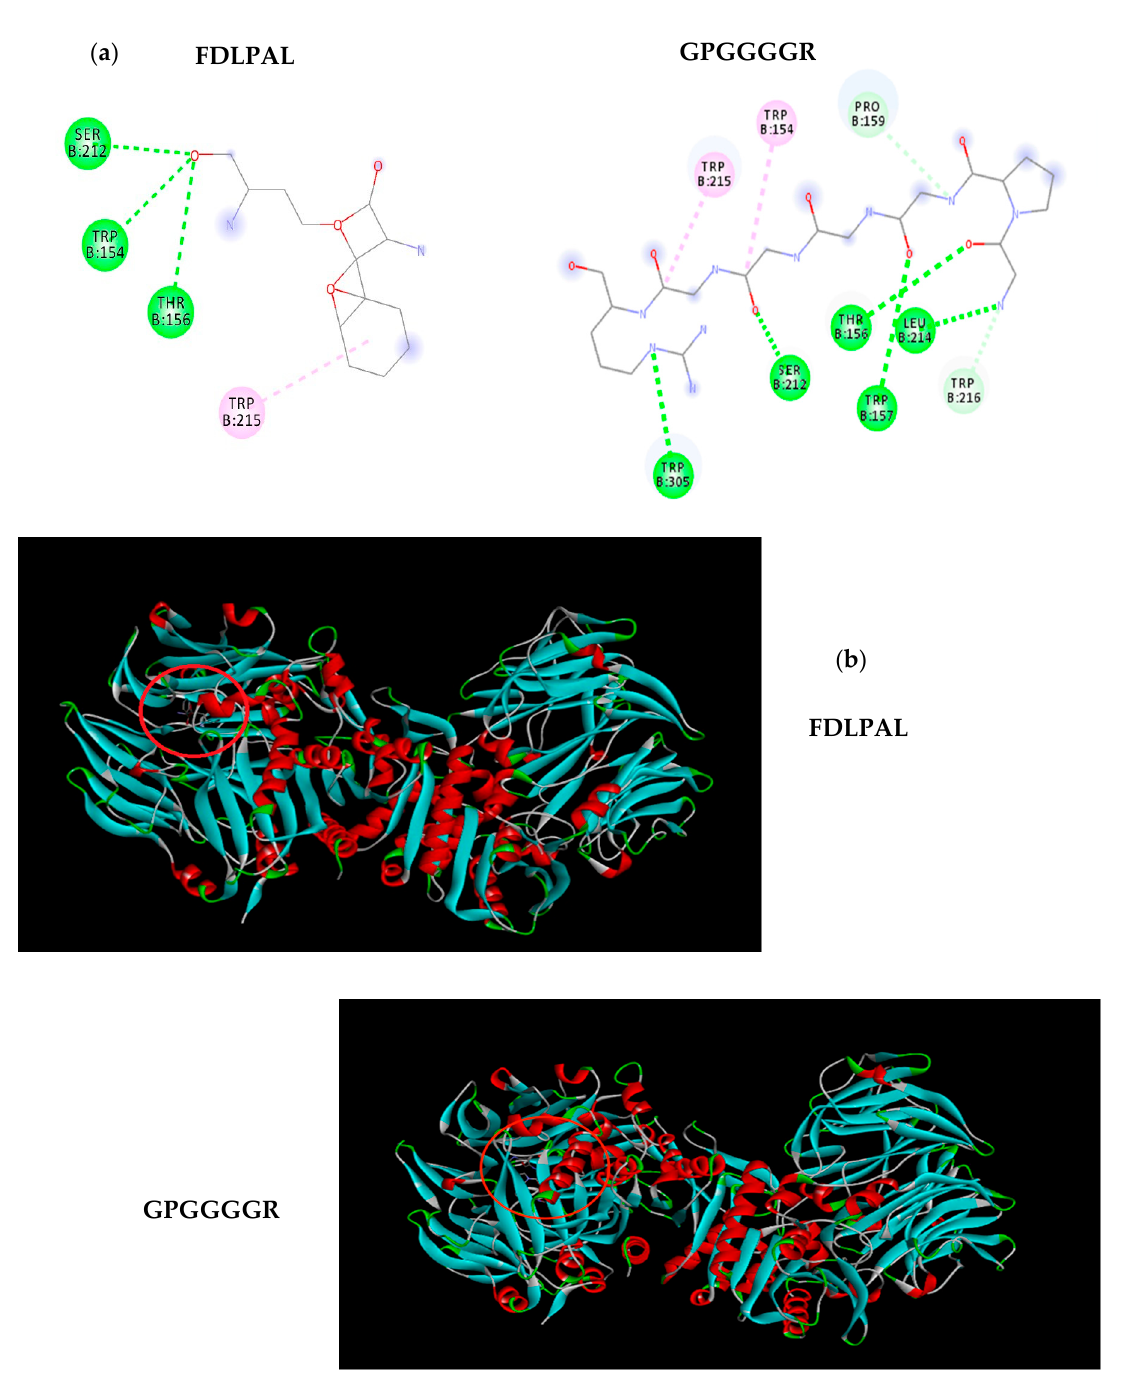
Figure 2. Docking interaction and DPPIV enzyme–peptide location for optimized chickpea bromelain hydrolysate peptide sequences FDLPAL and GPGGGGR. ( a ) FDLPAL, best pose of chickpea peptide Phe-Asp-Leu-Pro-Ala-Leu (structure in gray, left) in the molecular docking study of sequences with DPPIV. GPGGGGR, best pose of chickpea peptide Gly-Pro- Gly-Gly-Gly-Gly-Arg (structure in gray, right) in the molecular docking study of sequences with DPPIV. ( b ) Position of peptide Phe-Asp-Leu-Pro-Ala-Leu (circled in red, left) in the molecular docking study with DPPIV. Position of peptide Gly-Pro-Gly-Gly-Gly-Gly-Arg (circled in red, right) in the molecular docking study with DPPIV. SDS-PAGE profile and soluble protein (Figure S2 and Table 2) show the positive impact of the addition of the hydrolysates to the tortillas. The soluble protein of the composite CPH was 44.69 ± 2.23%. All CPH fortification ratios showed significant difference ( p <